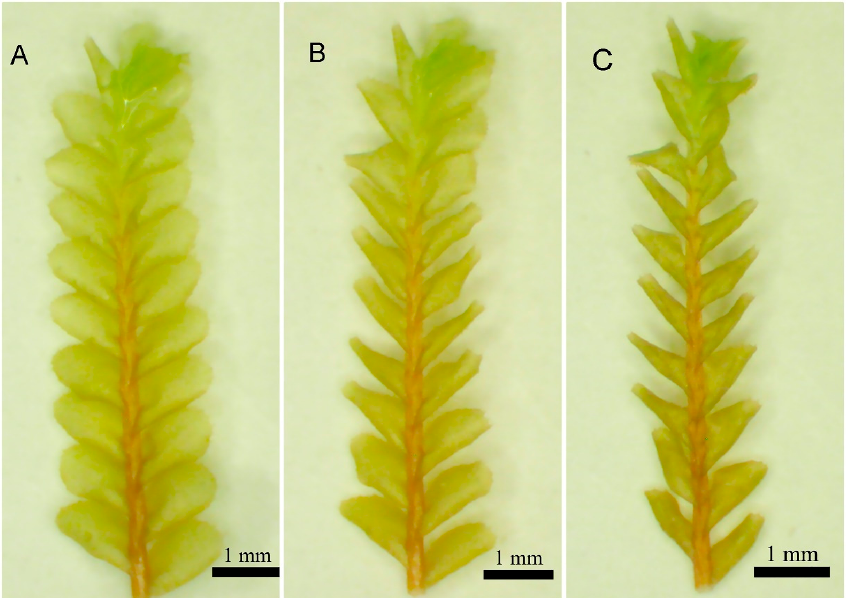
Figure 1. Plagiochila porelloides morphology visually changes with hydration status–dorsal view. ( A ) full hydrated condition, with no liquid water added; ( B ) partly desiccated condition; ( C ) completely dry condition, exhibiting highly contorted leaves.